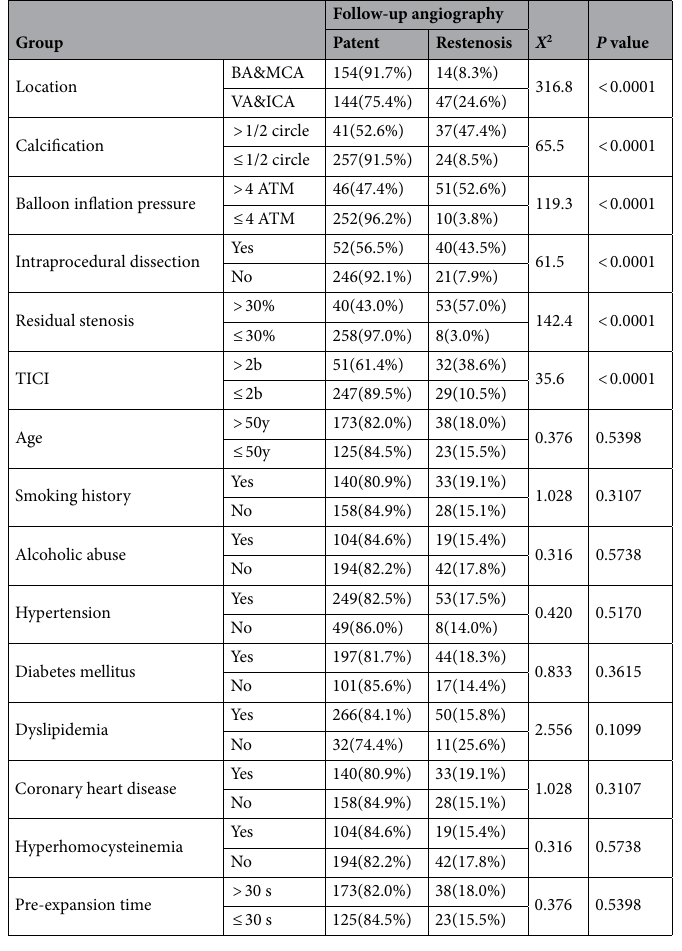
Table 2. Single factor analysis of risk factors for in-stent restenosis. BA, basilar artery; MCA, middle cerebral artery; VA, vertebral artery; ICA, internal carotid artery; TICI, thrombolysis in cerebral infarction grade.